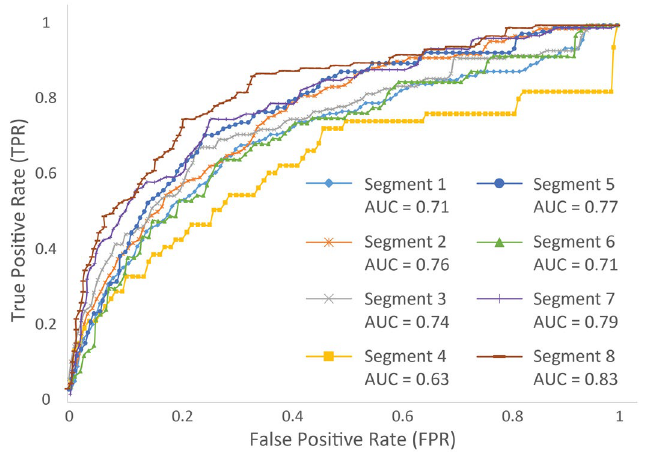
Figure 5. A receiver operating characteristic (ROC) analysis comparing in silico ScanFold −1 z-score predicted structures to DMS-MaPseq data for IAV (H1N1) segments 1–8. The true positive rate (TPR) is shown on the y-axis and the false positive rate (FPR) on the x-axis. Each segment is shown with a unique color and data point marker: segment 1, light blue and a diamond; segment 2, orange and an asterisk; segment 3, grey and an x; segment 4, yellow and a square; segment 5, dark blue and a circle; segment 6, green and a triangle; segment 7, purple and a cross; segment 8, maroon and a dash. The associated area under the curve (AUC) is shown below each segment in the